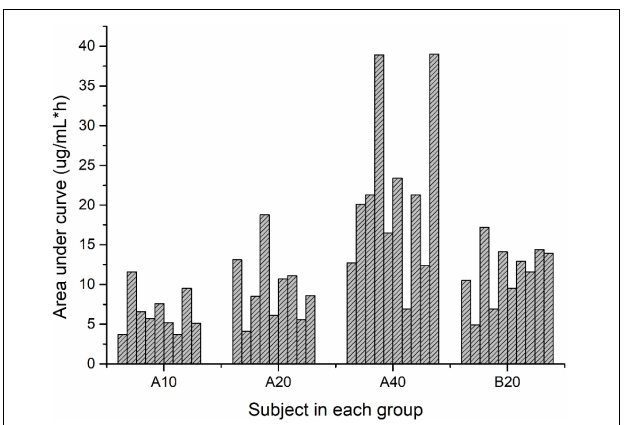
FIGURE 2 | Area under the curve for lutein concentration over time ( µ g/mL × h) for subjects in each